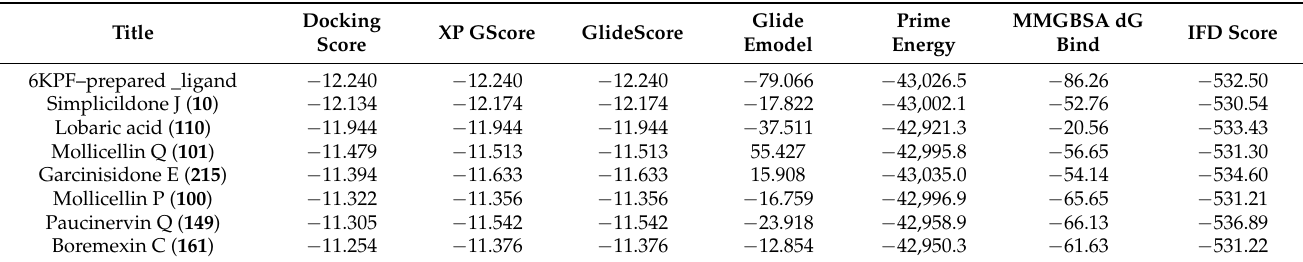
Table 1. Docking results of in silico screening against CB2 receptor (PDB-ID:6KPF) and binding free energy.